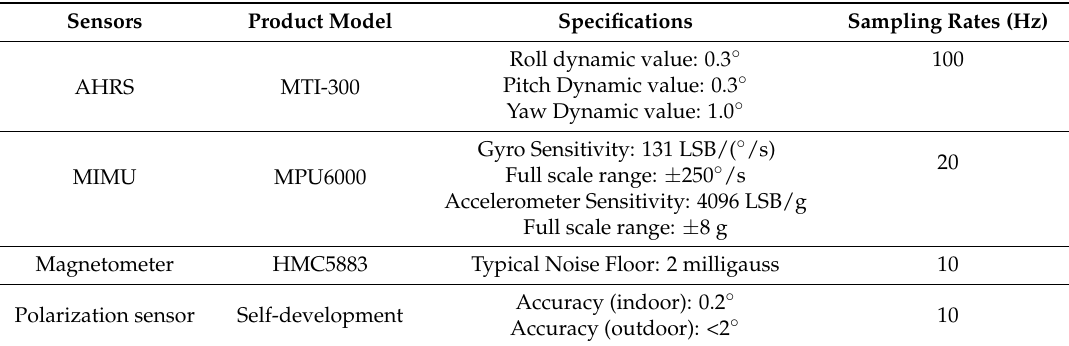
Table 1. The accuracy specifications of